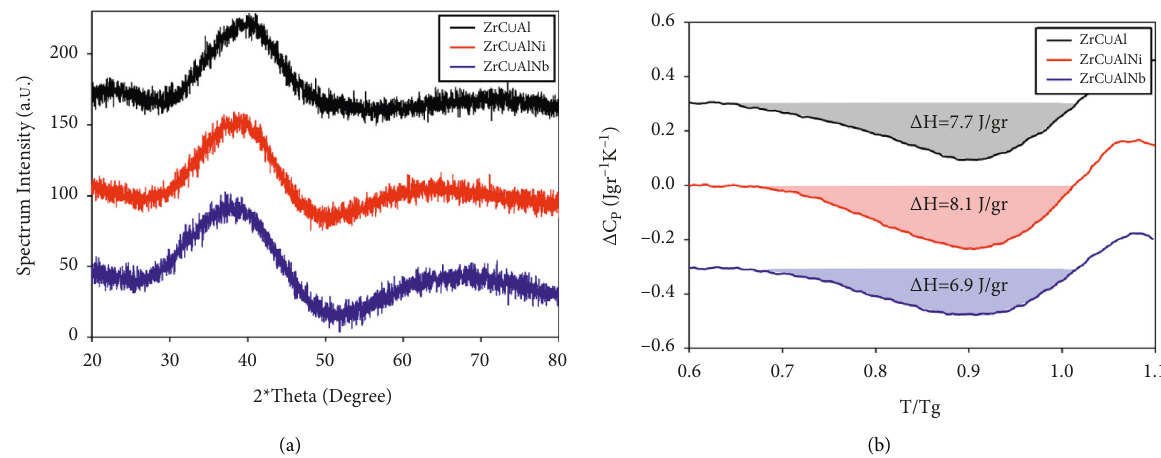
Figure 1: (a) XRD patterns and (b) DSC curves at the relaxation region for all the samples.